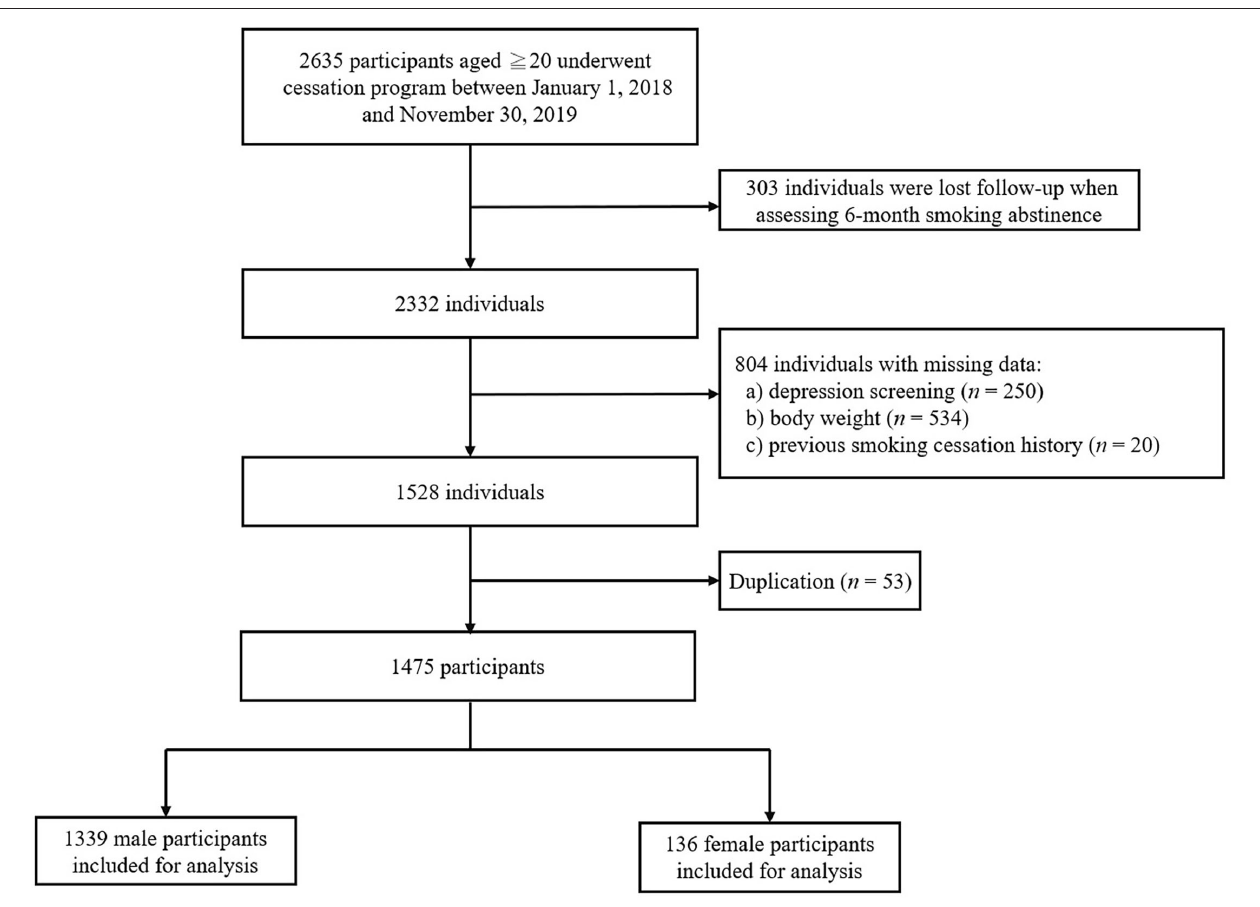
FIGURE 1 | Flow chart for inclusion of